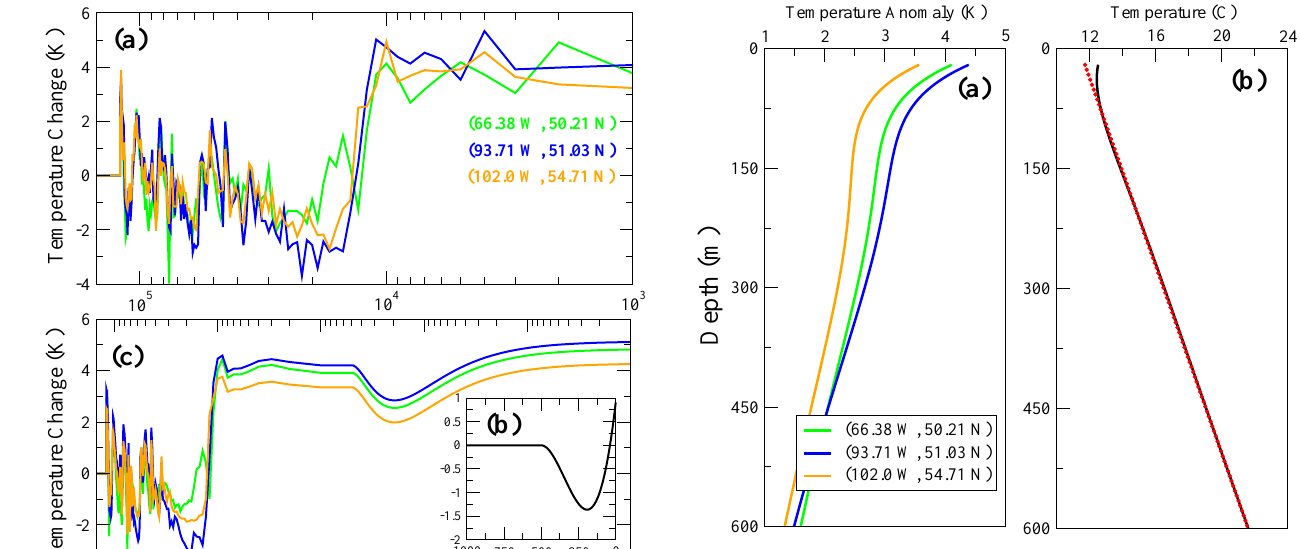
Fig. 5. (a) Subsurface temperature anomalies from the forcing functions in Figure4c. (b) To simulate the Figure 5. (a) Subsurface temperature anomalies from the forcing synthetic temperature versus depth profile shown, we added to the anomalies in (a) an assumed steady-state functions in Fig. 4c. (b) To simulate the synthetic temperature ver- withasurfacetemperatureof8 (cid:14) Candageothermalgradientof20,Kkm (cid:0) 1 (blacksolidline). Reddotsdenote sus the depth profile shown, we added to the anomalies in (a) an as- resultingthesteadystateasmodifiedbythesubsurfaceanomaliesin(a). sumed steady state with a surface temperature of 8 ◦ C and a geother- mal gradient of 20Kkm − 1 (black solid line). Red dots denote the et al. (2011). The resulting present-day subsurface temperature anomalies generated by the one- 325 steady state as modified by the subsurface anomalies in (a) dimensionalforwardmodelassumingisotropicthermophysicalpropertiesareshowninFigure5a. A long-term surface temperature of 8 (cid:14) C and a constant geothermal gradient of 20 Kkm (cid:0) 1 are added to these anomalies to generate a set of simulated BTPs based on the simulated locations from the MUN-GCM. These background steady-state conditions were chosen after Beltrami et al. (2011) for consistency. AnexampleofonecompletedBTPisshowninFigure5b. NotethatsimilarBTPswere 330 calculatedateachgridpointacrossthemodeleddomainandusedinthestandardinversionprocedure described in Section2.2. AfterconstructingthesyntheticBTPsasdescribedabove,theprofilesareprocessedinexactlythe same manner as real-world observations. The lower section of each BTP is fit to a linear function, which is subtracted from the whole BTP to form a temperature anomaly. Figure6 shows three 335